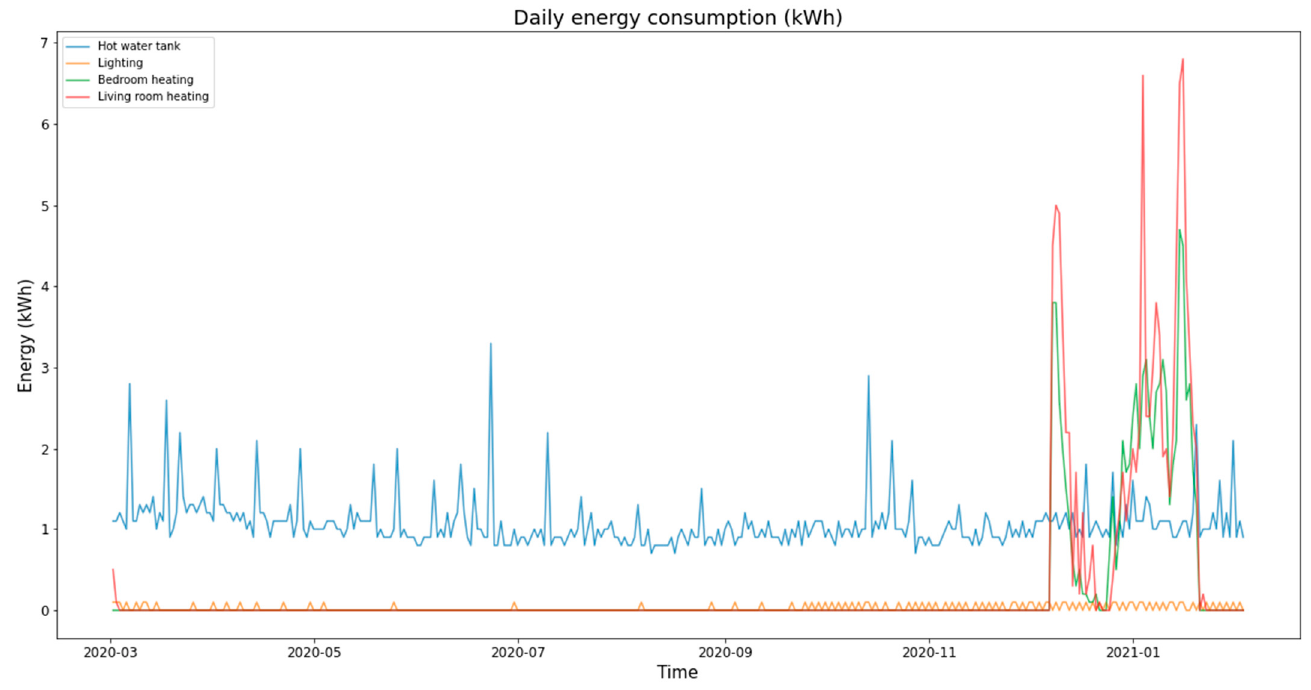
Figure 26. Energy consumption.